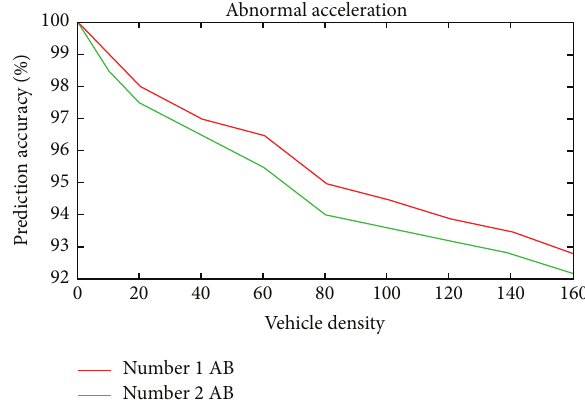
Figure 12: Prediction accuracy versus vehicle density for Scenario 2.